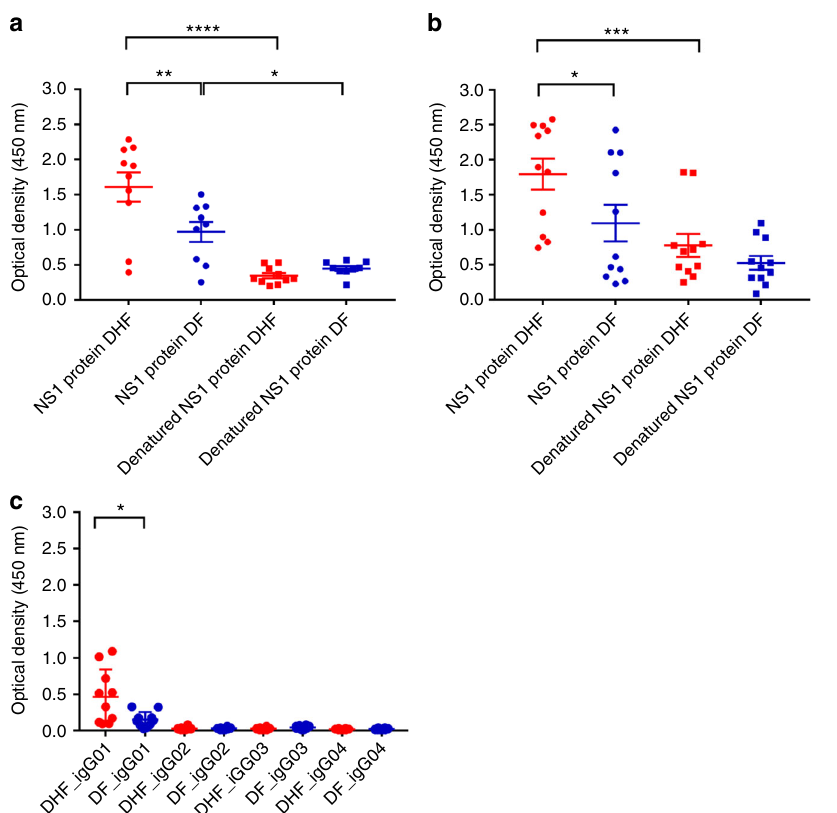
Fig. 8 DENV NS1 antibody responses to recombinant and denatured NS1. a DENV1 NS1-speci fi c IgG antibody responses to recombinant DENV1 NS1 and denatured DENV1 NS1 were measured by ELISA in patient s with DF ( n = 10) and DHF ( n = 10) on day 7 of illness. b DENV2 NS1-speci fi c IgG antibody responses to recombinant DENV2 NS1 and denatured DENV2 NS1 were measured by ELISA in patients with DF ( n = 10) and DHF ( n = 10) on day 6 of illness. c DENV2 NS1-speci fi c IgG subclasses to DENV-2 NS1 protein were measured in patients with DF ( n = 10) and DHF ( n = 10) on day 6 of illness. Differences in mean values between antibody responses to NS1 protein in patients with DF and DHF were compared using the Mann – Whitney U test (two tailed). Error bars indicate mean and standard deviation (SD). * P < 0.05, ** P < 0.01, *** P < 0.001, **** P <